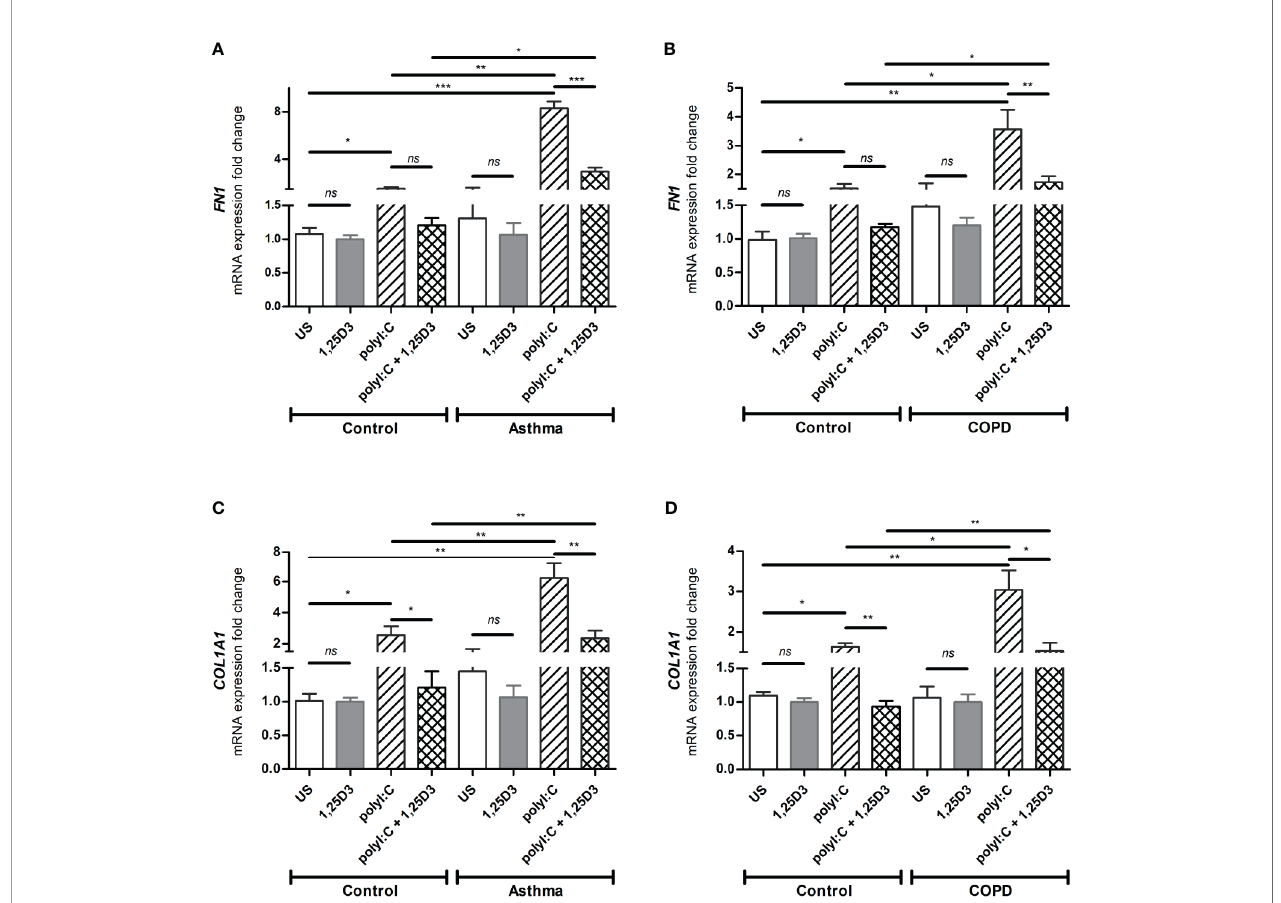
FIGURE 5 | mRNA expression of FN1 (A, B) and COL1A1 (C, D) in BSMCs from asthma (A, C) and COPD (B, D) compared to BSMCs from healthy control groups. n = 4 asthma, n = 3 healthy controls, n = 4 COPD, and n = 3 healthy control smokers. qRT-PCR data is representative of two independent experiments. One way ANOVA using Newman-Keuls multiple comparison test were performed to assess statistical signi fi cance between groups. Mean ± SE; ( ns ) p > 0.05, no signi fi cant difference, * p < 0.05, ** p < 0.01, *** p <